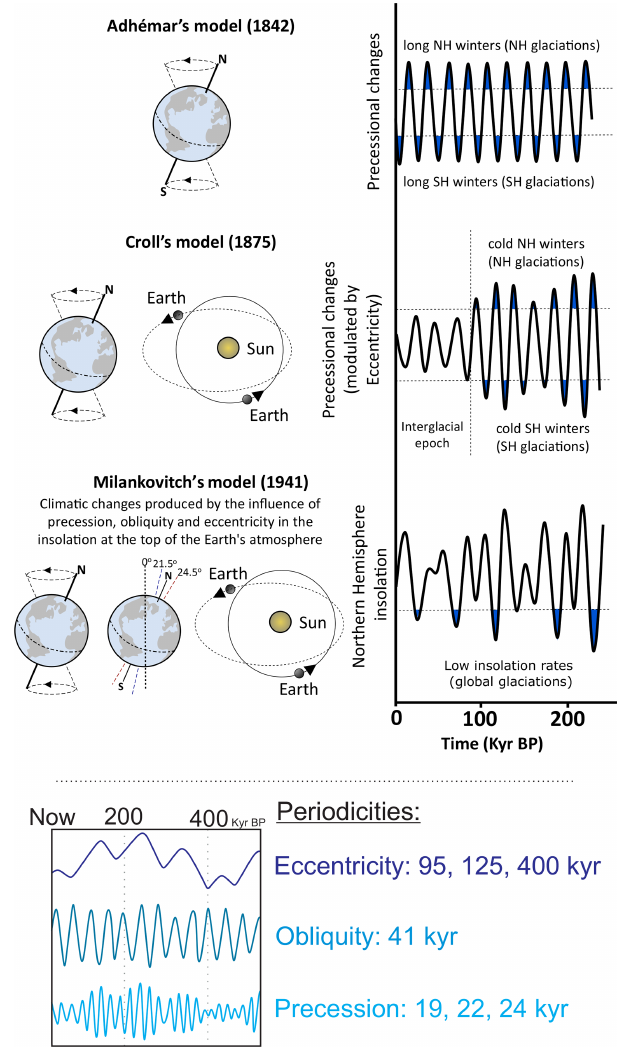
Figure 2. Orbital models for glacial cycles. Adhémar’s model con- siders only precession to explain cyclic glaciations alternating be- tween hemispheres. Croll’s model considers the interferences of ec- centricity. The last is Milankovitch’s model, a pioneer in determin- ing the insolation calculated from all orbital parameters (modified from Paillard,